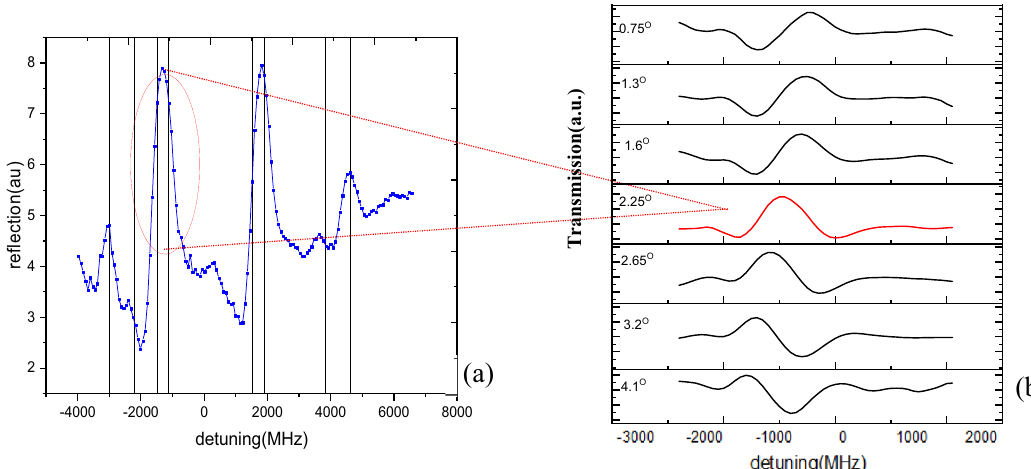
Figure 2. ( a ) Reflectance spectra of D1 hyperfine transitions in coupled atomic plasmonic structure. ( b ) angular modulation of selected transition line about 2.25 degree (SP resonance induced angle of incidence), for selected hyperfine transition line of rubidium metal marked by red